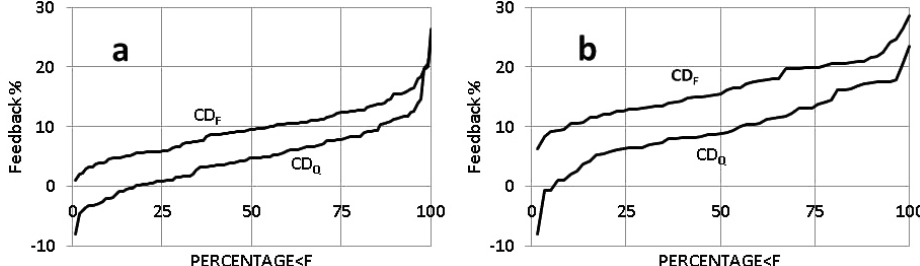
Figure 8. Comparison of CD Q and CD F with mean 20-day (a) rainfall quantity and (b) frequency of occurrence, preceding key